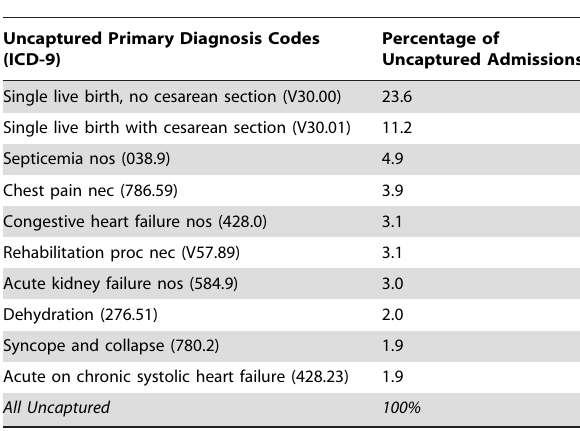
Table 2. Top ten most frequent diagnoses not captured by GBD 2010 primary diagnosis codes.